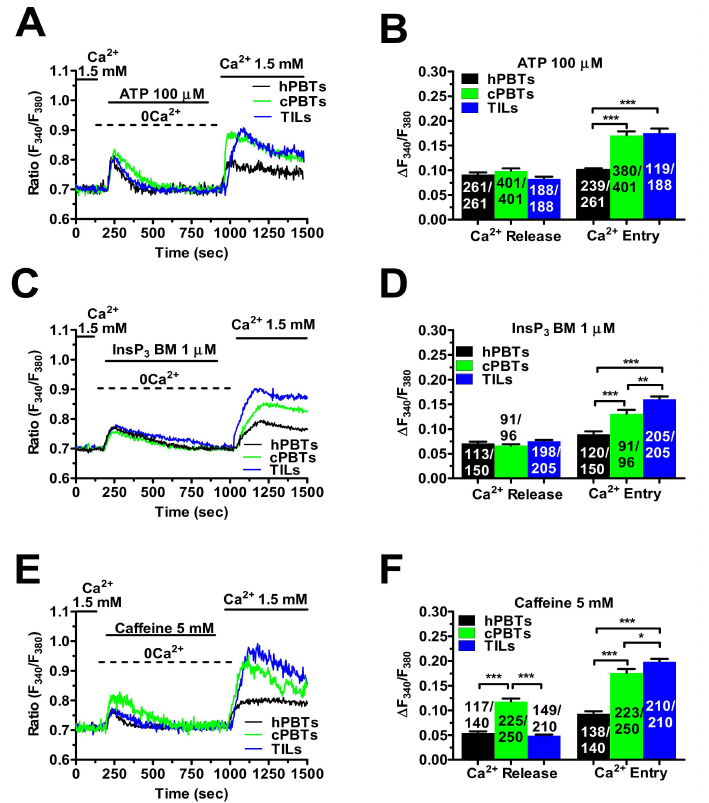
Figure 3. SOCE induced by ER Ca 2+ depletion through InsP 3 Rs and RyRs is enhanced in TILs. ( A ) The ER Ca 2+ pool was depleted by challenging the cells with the InsP 3 -producing autacoid, ATP (100 µ M) in the absence of external Ca 2+ (0Ca 2+ ). Under 0Ca 2+ conditions, ATP evoked a transient increase in [Ca 2+ ] i that rapidly returned to the baseline upon clearance of cytosolic Ca 2+ by mitochondria, SERCA, NCX and PMCA [26,37,38]. Subsequently, SOCE was evaluated by replenishing Ca 2+ (1.5 mM) to the perfusate in the absence of the agonist, which was removed 100 sec before re-addition of extracellular Ca 2+ . ( B ) Mean ± SE of the amplitude of ATP-induced intracellular Ca 2+ release and SOCE in hPBTs, cPBTs and TILs. One-way ANOVA followed by the post hoc Bonferroni test: *** p < 0.001. ( C ) The ER Ca 2+ pool was depleted by challenging the cells with InsP 3 BM (1 µ M) in the absence of external Ca 2+ (0Ca 2+ ). Under 0Ca 2+ conditions, InsP 3 BM evoked a transient increase in [Ca 2+ ] i that rapidly returned to the baseline upon clearance of cytosolic Ca 2+ by mitochondria, SERCA, NCX and PMCA [38]. Subsequently, SOCE was evaluated by replenishing Ca 2+ to the perfusate (1.5 mM) in the absence of the agonist, which was removed 100 sec before re-addition of extracellular Ca 2+ . ( D ) Mean ± SE of the amplitude of InsP 3 BM-induced intracellular Ca 2+ release and SOCE in hPBTs, cPBTs and TILs. One-way ANOVA followed by the post hoc Bonferroni test: ** p < 0.01 and *** p < 0.001. ( E ) The ER Ca 2+ pool was depleted by challenging the cells with caffeine (5 mM), a selective RyR agonist, in the absence of external Ca 2+ (0Ca 2+ ). Under 0Ca 2+ conditions, caffeine evoked a transient increase in [Ca 2+ ] i that rapidly returned to the baseline upon clearance of cytosolic Ca 2+ by mitochondria, SERCA, NCX and PMCA [40]. Subsequently, SOCE was evaluated by replenishing Ca 2+ to the perfusate (1.5 mM) in the absence of the agonist, which was removed 100 sec before re-addition of extracellular Ca 2+ . ( F ) Mean ± SE of the amplitude of caffeine-induced intracellular Ca 2+ release and SOCE in hPBTs, cPBTs and TILs. One-way ANOVA followed by the post hoc Bonferroni test: * p < 0.05 and *** p < 0.001. In panels ( B , D , F ), the numbers within or above the histogram bars indicate the number of responding cells over the total number of analysed